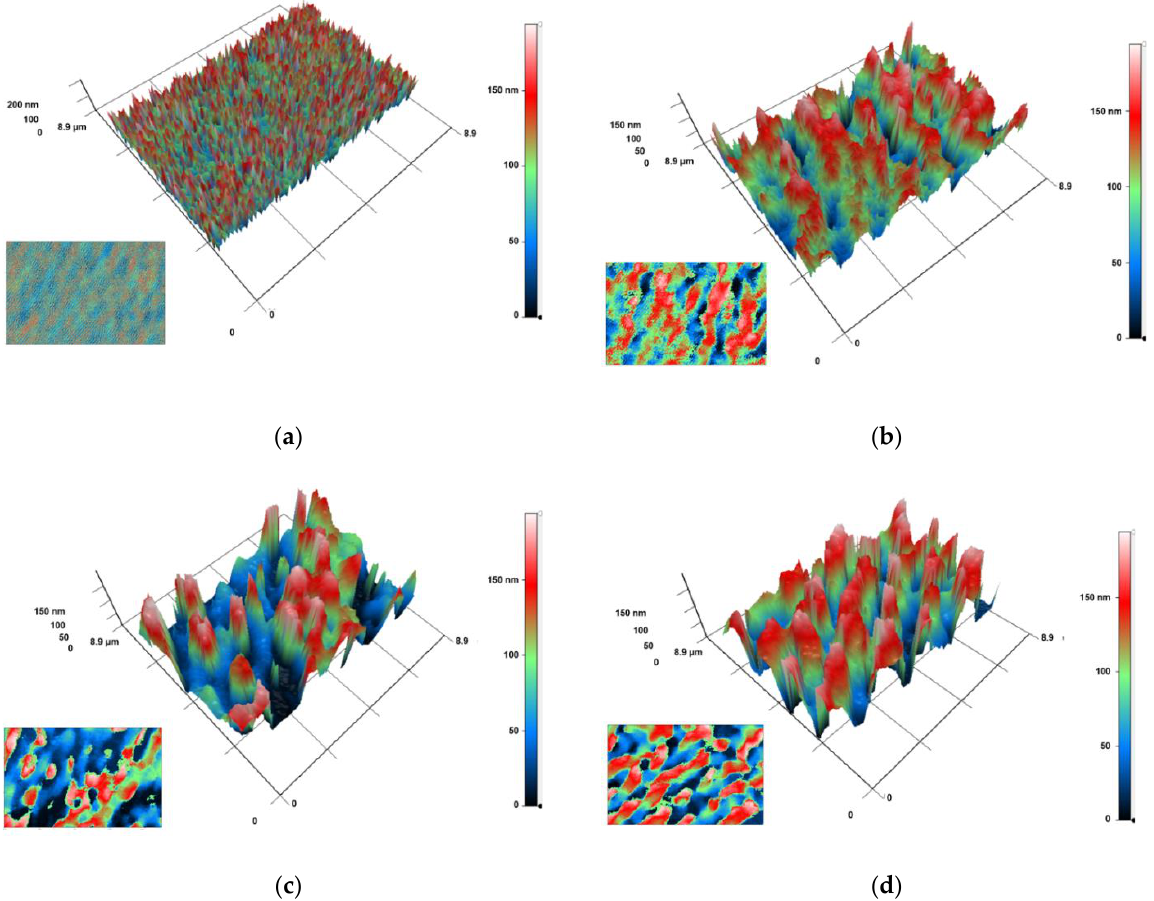
Figure 5. Images were obtained using a modulation interference microscope: ( a ) Polymer without NPs ( b ) and polymers with Al 2 O 3 NPs at a concentration of 0.001%; ( c ) At a concentration of 0.01%; ( d ) At a concentration of 0.1%. Three-dimensional reconstructions of sample surfaces are presented. The X and Y axes show the actual size of the studied surfaces in micrometers. The Z-axis shows the surface relief as a phase change expressed in nm. Top view (surface elevation map) is shown in the lower left corner of each figure.